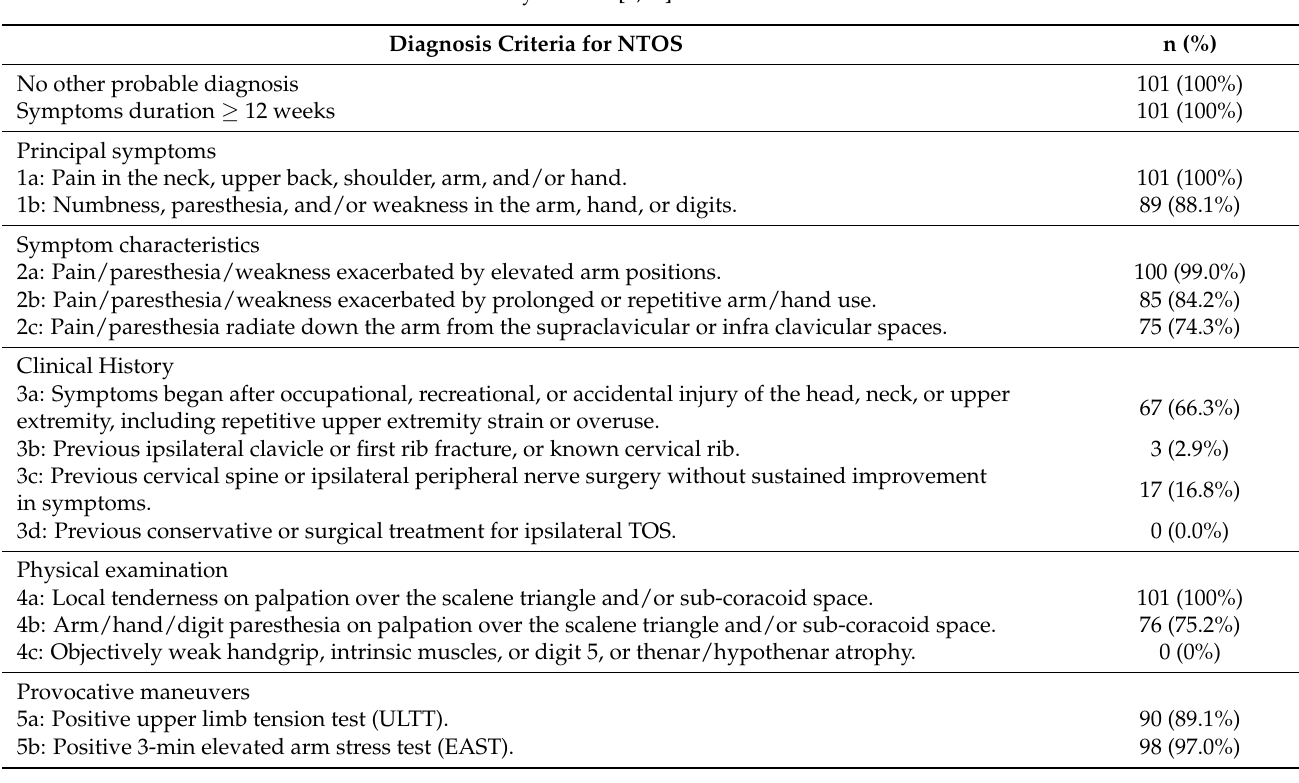
Table 1. Patients with clinical diagnosis criteria for neurogenic thoracic outlet syndrome (NTOS) according to Consortium for Research and Education on thoracic outlet syndrome